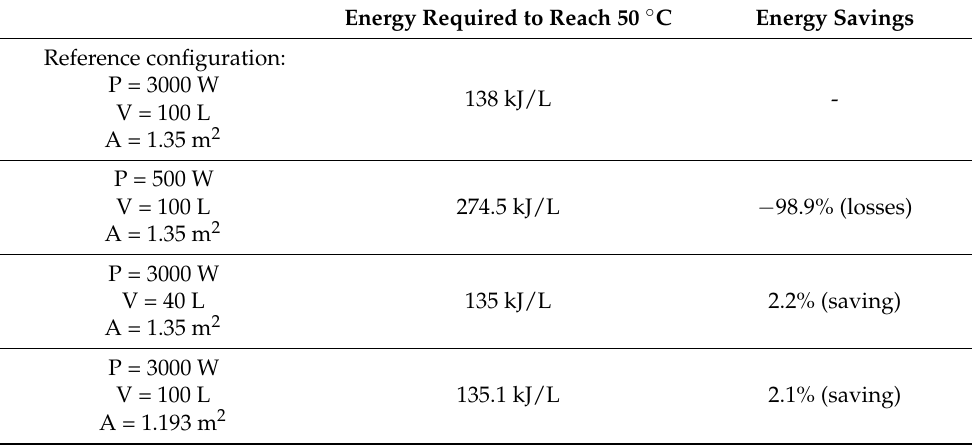
Table 5. Summary of results: potential energy